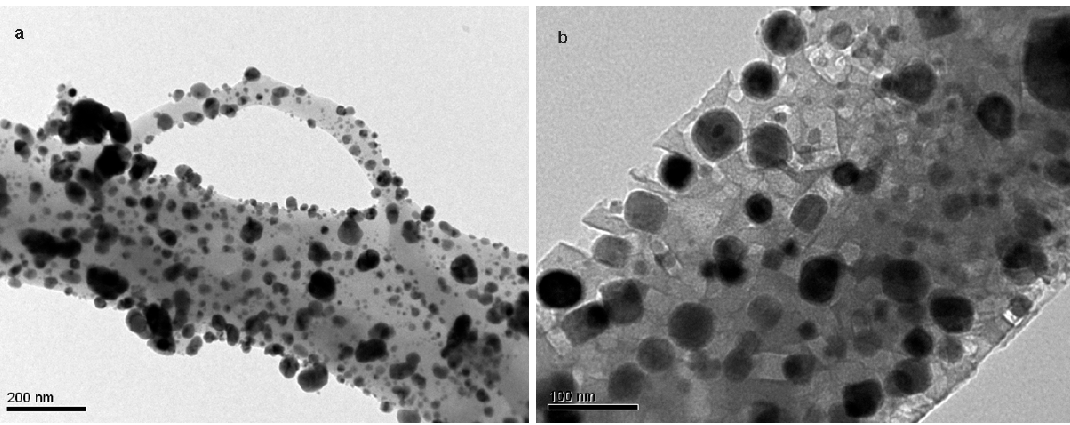
Figure 8. TEM of Ni/CAG 90 ( a ) and Fe/CAG 90 ( b ).